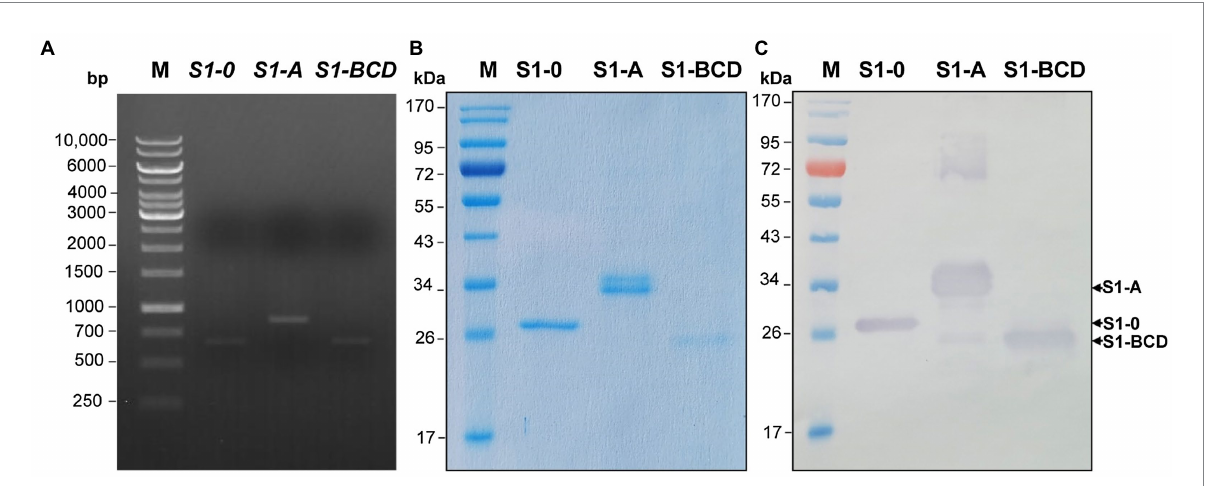
FIGURE 3 Production of recombinant polypeptides of PEDV S1 subunit (S1-0, S1-A, and S1-BCD). (A) PCR amplificons of the DNA sequences coding for the S1-0 (651 bp), S1-A (873 bp), and S1-BCD (660 bp). Lane M, 1 kb DNA ladder. The numbers on the left are DNA sizes in bp. (B) SDS-PAGE- separated patterns of the purified S1-0 (26 kDa), S1-A (32 kDa), and S1-BCD (24 kDa) after staining with CBB dye. (C) Western blot patterns of the purified S1-0, S1-A, and S1-BCD as detected by mouse anti-6× His antibody. Lanes M of (B) and (C) are protein molecular mass markers. The numbers on the left of (B) and (C) are protein molecular masses in